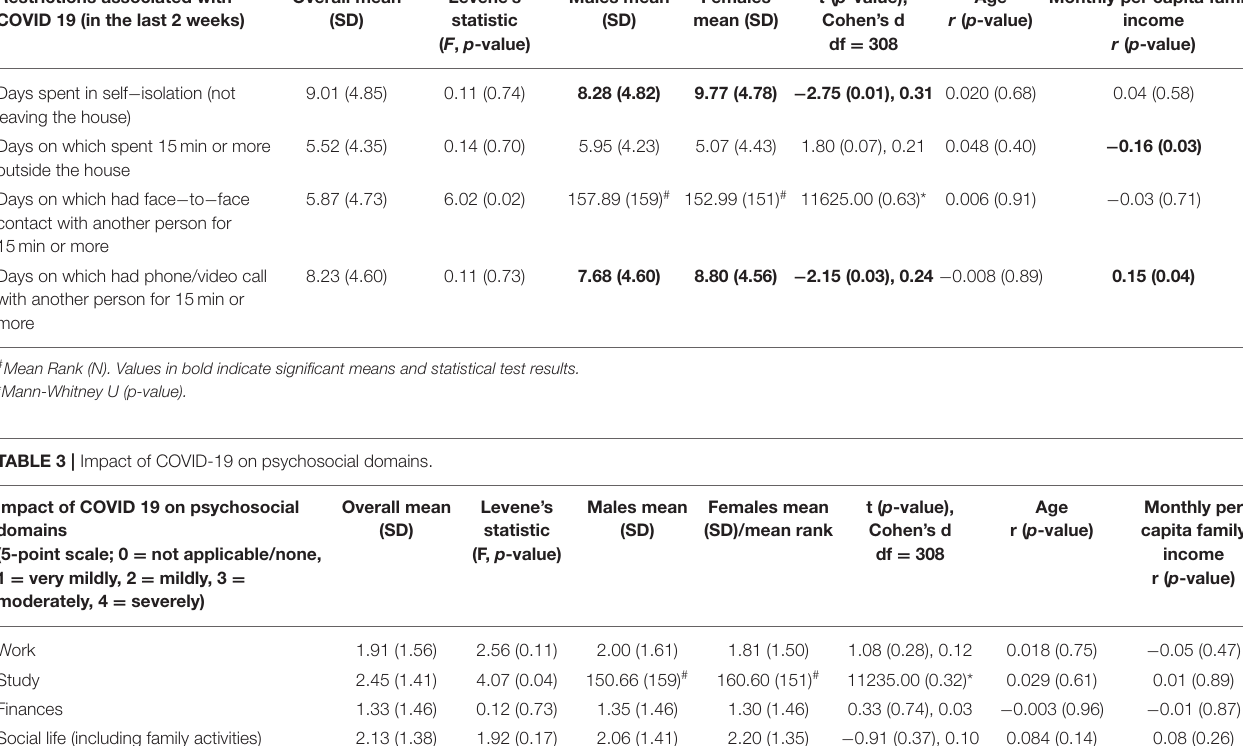
TABLE 2 | Restrictions associated with COVID − 19. Restrictions associated with COVID 19 (in the last 2 weeks)